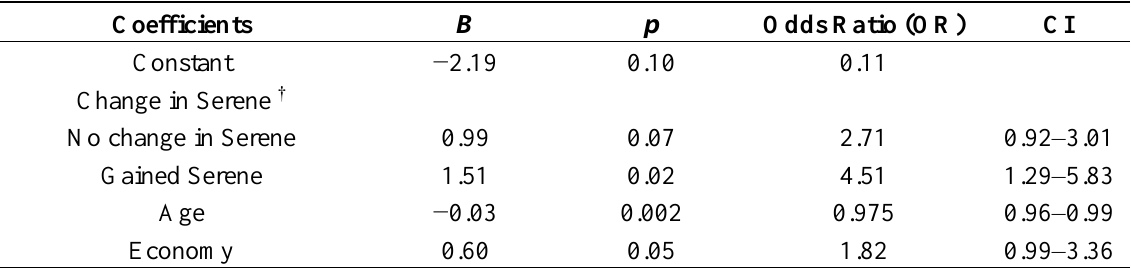
Table 4. Chance of getting improved mental health (dependent variable) among women in relation to the categorical exposure variable “access to Serene” and the other significant independent variables age and economy ( n =